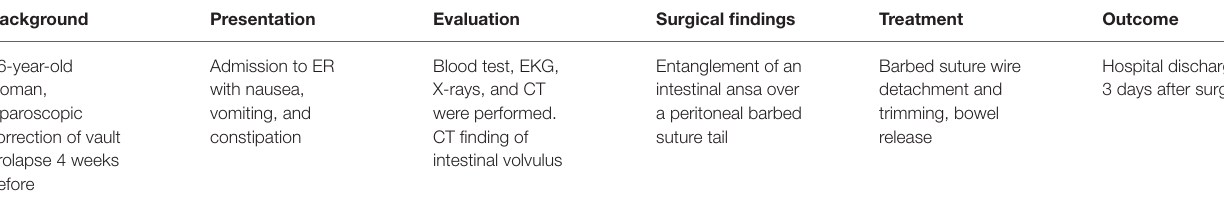
TABLE 2 | Summary of case